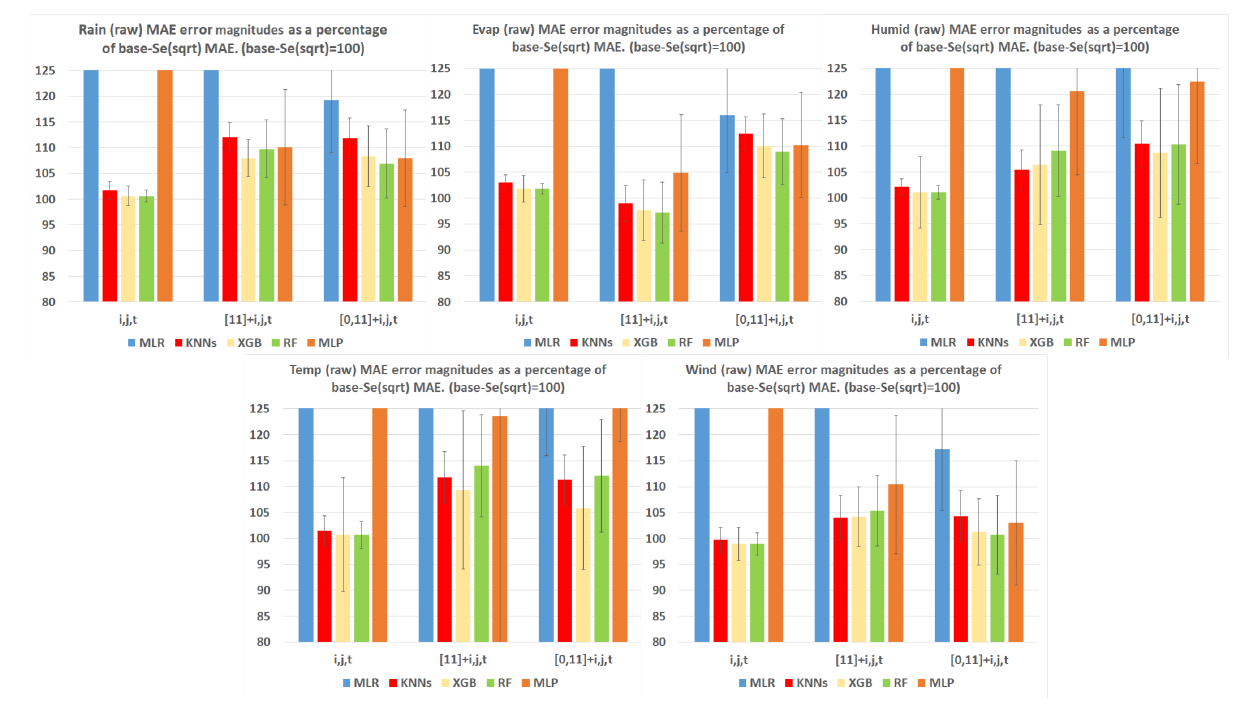
Figure 12. MAE of all trained models with features [i,j,t, i,j,t+[11], i,j,t+[0,11]], compared to base-Se(sqrt) on the raw climate datasets. On the vertical scales, 100 corresponds to the MAE for the base-Se(sqrt) estimator.